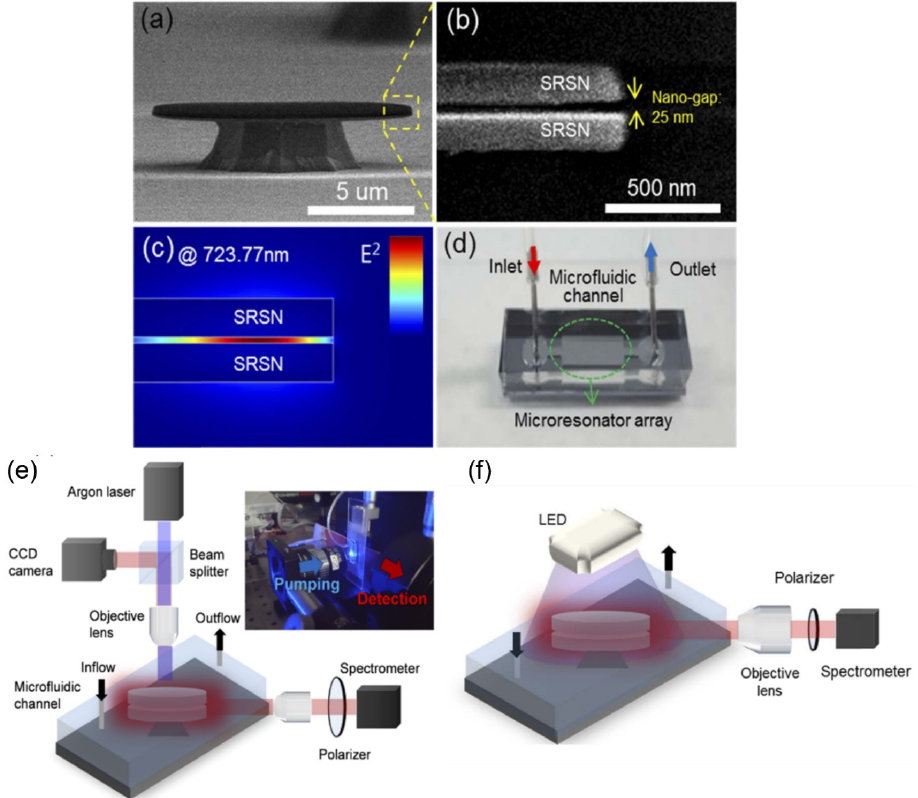
Figure 21. ( a , b ) SEM image of the microdisk resonator with a slot. ( c ) Intensity profile between the disks. ( d ) Microfluidic channel with the microdisk arrays. ( e ) Schematic of the proposed system. ( f ) Schematic of the system based on LED source. Reproduced from ref. [130] with permission © The Optical Society of America.